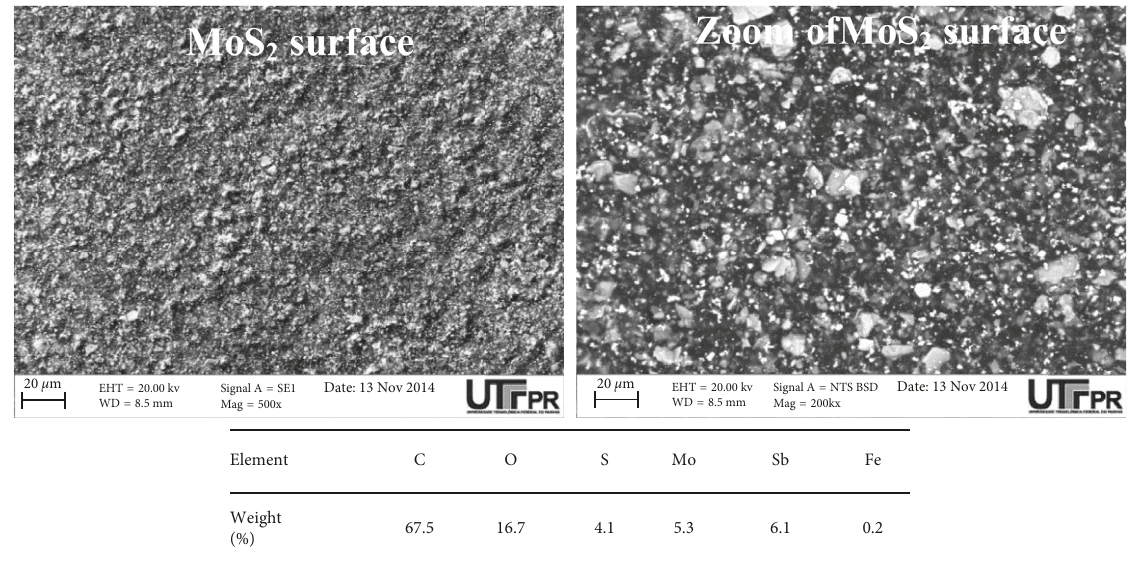
Figure 9: SEM surface image of the MoS 2 surface (a and b) and EDS analysis of the global surface.